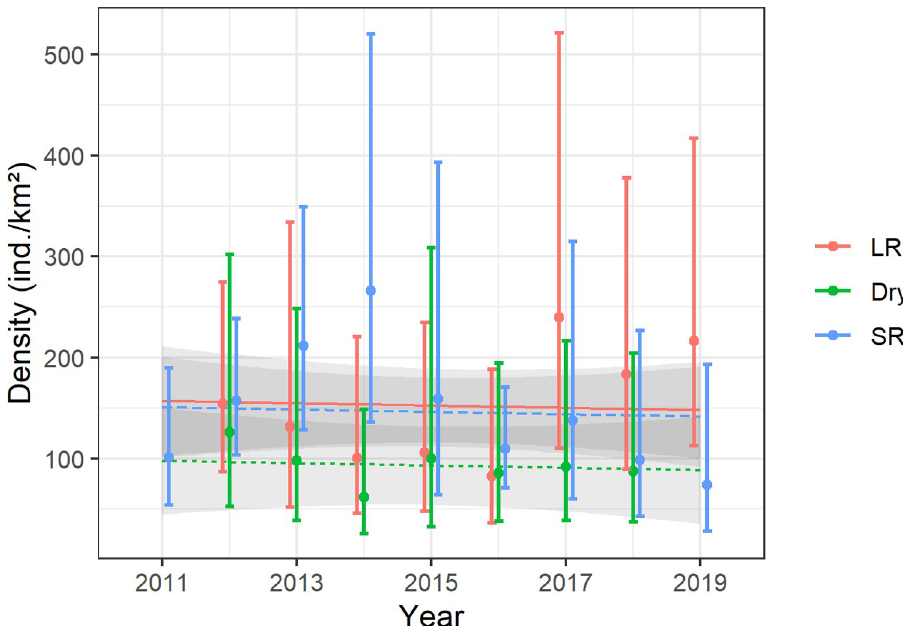
Fig 5. Seasonal (LR: Long rains; Dry: Dry season; SR: Short rains) density estimates and associated 95% confidence intervals of olive baboons in Lake Manyara National Park (Tanzania) from 2011–2019 (one survey in 2011; three surveys per year from 2012–2018, two surveys in 2019) and seasonal trend lines based on a general additive model.